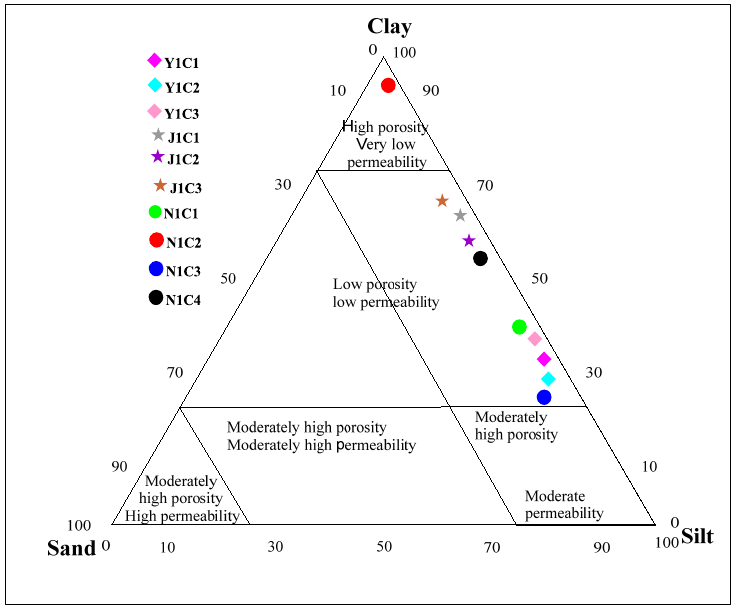
Figure 11. Porosity and permeability of clay materials of the eastern part of Douala sub-basin in the triangular diagram after